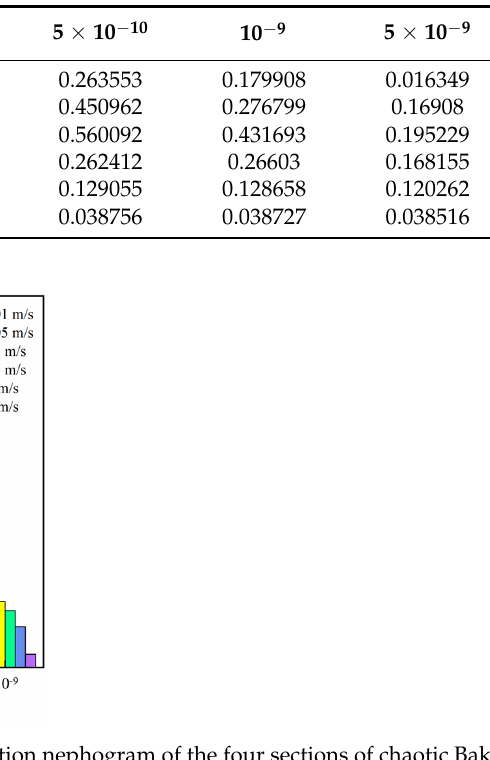
Figure 9. 𝑁𝑈𝐶𝑁 value of concentration distribution nephogram of the four sections of chaotic Baker pipeline.